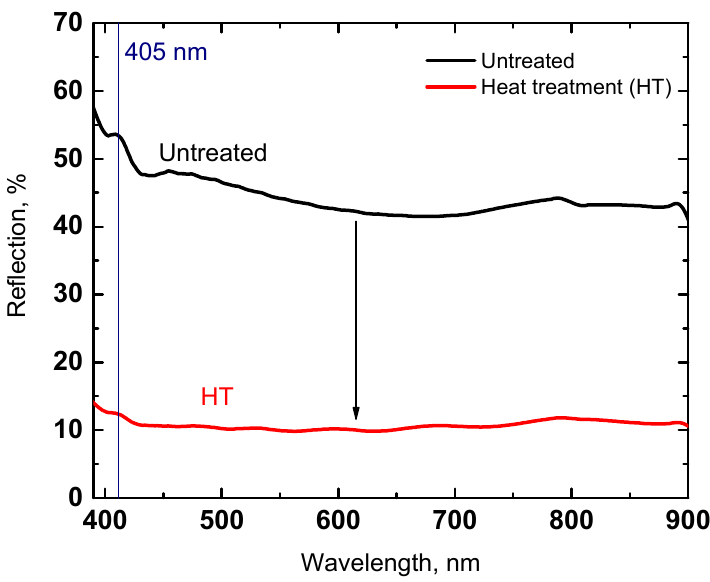
Figure 4. Reflection spectra of PbSe film: untreated (black curve), after heat treatment (red curve).